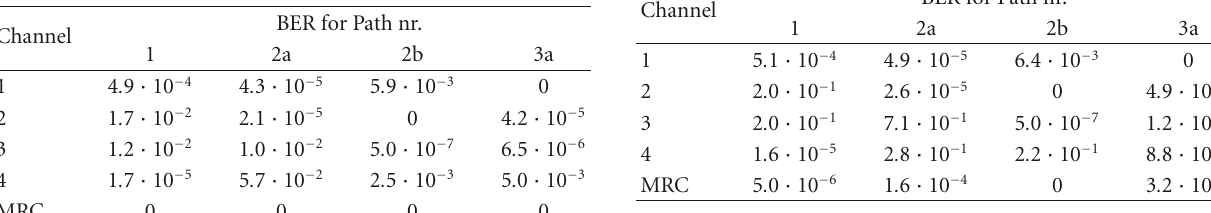
Table 4: BERs for a number of NLoS situations; for each individual antenna and for the (MRC) combined signal. Channel tracking always on the MRC signal.